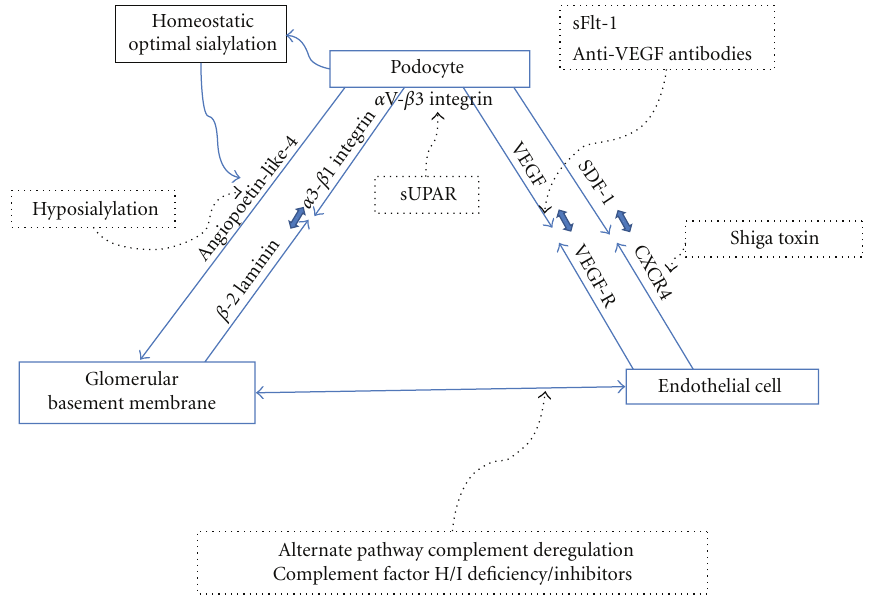
Figure 1: Components of the Glomerular filtration barrier with examples of crosstalk. This figure summarizes important signaling interactions between the 3 key components of the GFB and their putative involvement in human disease models (dotted arrows). Podocyte α 3- β 1 integrin interacts with GBM β -2 laminin; hyposialylated-podocyte-secreted Angp-4 may have an e ff ect on the GBM and the endothelial cell in MCD models. sUPAR, a potential circulating “serum factor,” a ff ects podocyte α V- β 3 integrin in primary FSGS. Podocyte- endothelial cell interactions are a ff ected by VEGF/VEGF-R blocking agents in preecclampsia while SDF-1-CXCR4 pathway is perturbed by Shiga toxins in HUS. Alternate pathway complement dysregulation and consequent endothelial components are central to MPGN and atypical